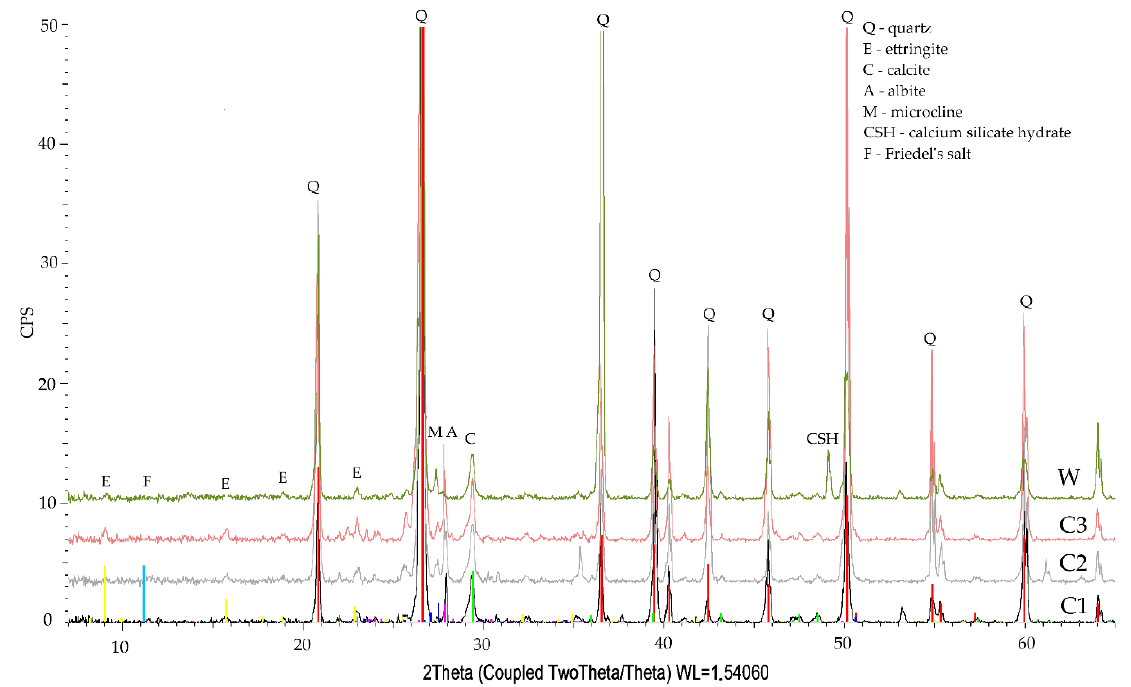
Figure 5. Diffraction pattern of specimen slices No. 1, 2, 3 (C1, C2, C3) after chloride ion diffusion, against the background of the specimen stored in tap water (W).